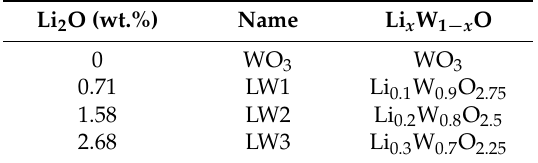
Table 1. Samples with different amounts of Li 2 O doping in WO 3 .